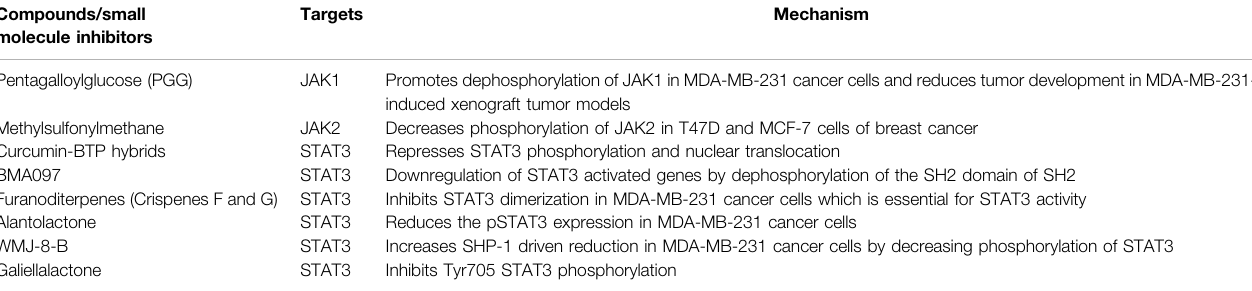
TABLE 6 | JAK/STAT signaling modulators, their targets, and mechanism in breast cancer/cells. Compounds/small molecule inhibitors